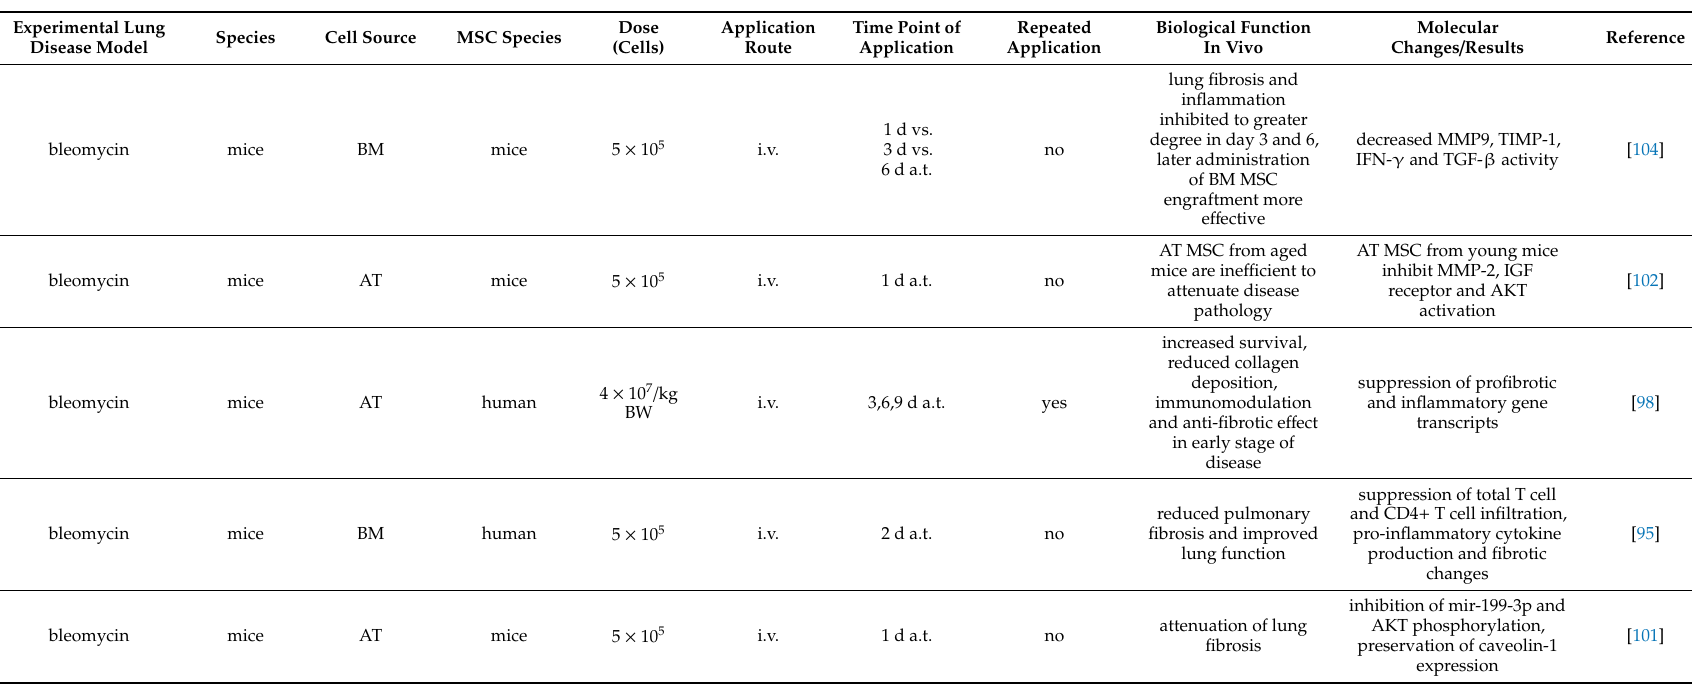
Table 5. Summary of important preclinical studies in rodents on the therapeutic e ffi cacy of MSC to treat Idiopathic pulmonary